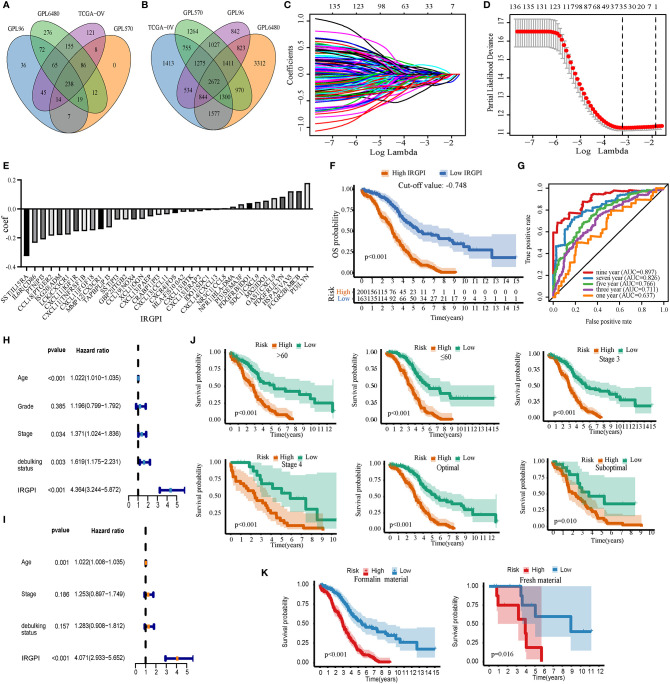
Build and verify immune-related gene pair index (IRGPI) in the training set. (A) Venn map of immune genes. (B) Venn diagrams of immune gene pairs. (C) The diagram of lambda and coef. (D) Partial likelihood deviance corresponding to different models. (E) The coef value corresponding to each gene. (F) IRGPI’s Kaplan-Meier curve of overall survival in the TCGA-OV cohort. (G) The ROC curve of IRGPI in TCGA-OV cohort. (H) Forest map based on single factor cox analysis. (I) Forest map based on multivariate cox analysis. (J) Kaplan-Meier analyzed IRGPI under different clinical types. (K) Kaplan-Meier analyzed IRGPI under formalin-fixed paraffin-embedded material and fresh material. P < 0.05 indicates that it is statistically significant.